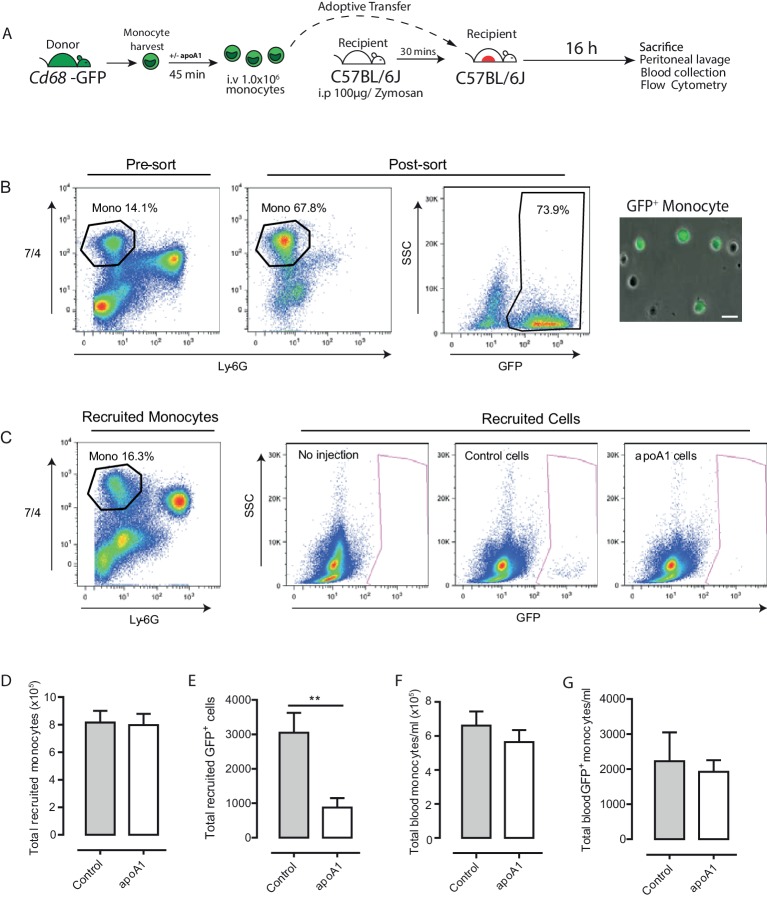
Acute exposure to apoA1 reduces the recruitment of adoptively transferred monocytes to sites of inflammation in vivo.Diagram of the experimental design presented in (A). Monocytes were isolated from Cd68-GFP bone marrow using ‘no-touch’ negative immunomagnetic selection (B). Isolated monocytes were characterized as 7/4high/Ly6Glow, with a typical yield of 65–70% monocytes, of which 70–80% were GFP positive. Isolated Cd68-GFP monocytes (1 × 106) treated for 45 min with either apoA1 (40 μg/ml) or PBS and were adoptively transferred into C57BL/6J mice by i.v. injection 30 min after i.p. injection with 100 μg zymosan. Mice were euthanized at 16 hr, and peritoneal lavage and blood samples were collected. Representative flow cytometry plots of peritoneal lavage from C57BL/6J mice that received adoptively transferred GFP positive monocytes treated with or without apoA1 during ongoing zymosan-induced peritonitis (C). Total monocytes and total adoptively transferred GFP+ monocytes were quantified in peritoneal lavage (D–E) and blood (F–G). Data are expressed as mean + SEM of 8–10 mice from two independent experiments. Statistical analysis was conducted by paired Students T test. **p,0.01, relative to control.